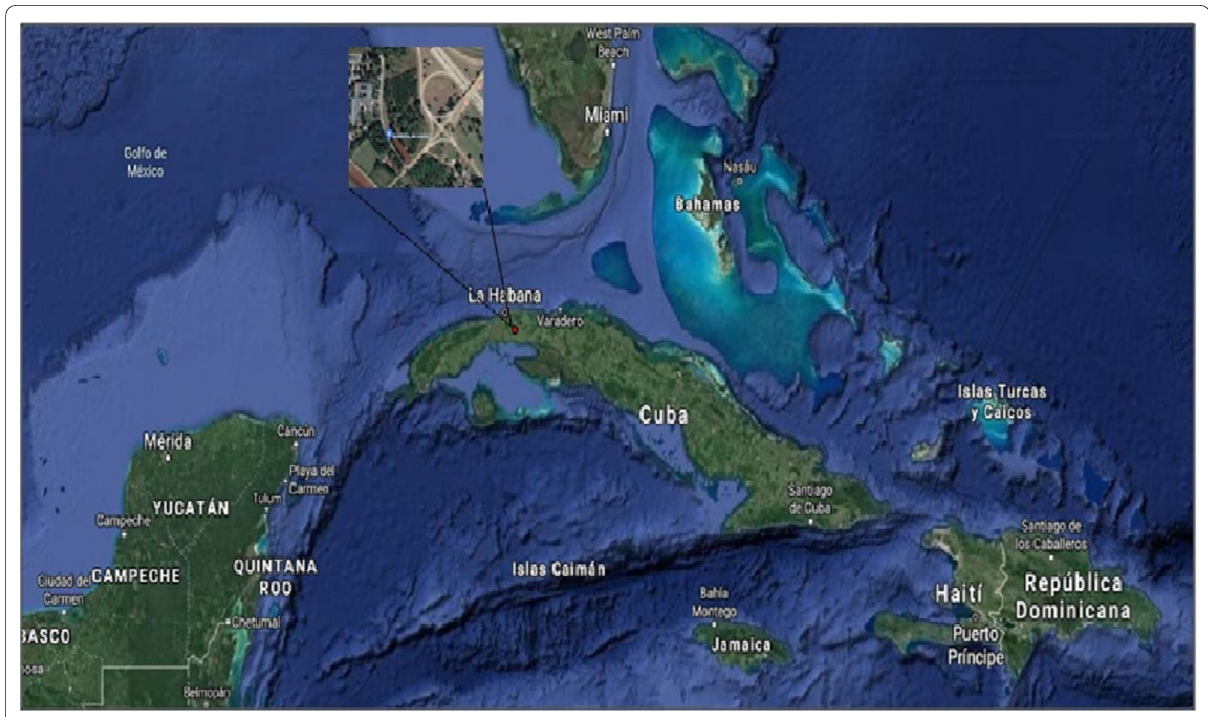
Fig. 1 Geo-localization of the plant material of Leea